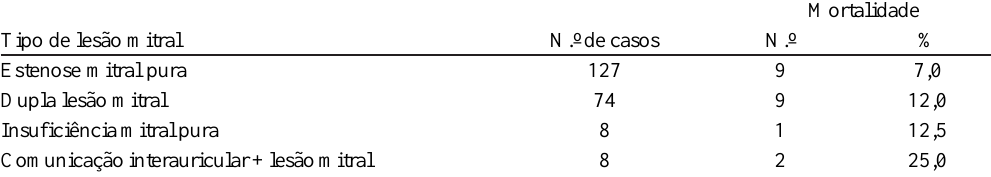
Tabela 1. Circulação extracorpórea: lesões da valvula mitral em 217 casos operados Tipo de lesão mitral Estenose mitral